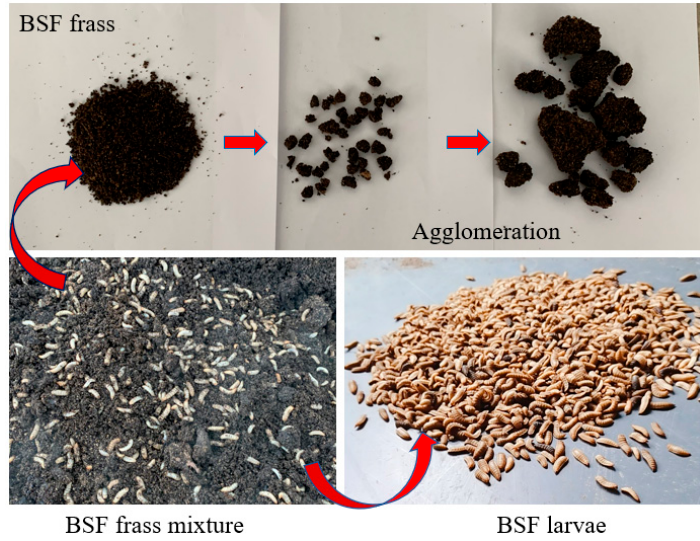
Figure 1. The main components of black soldier fly feces.